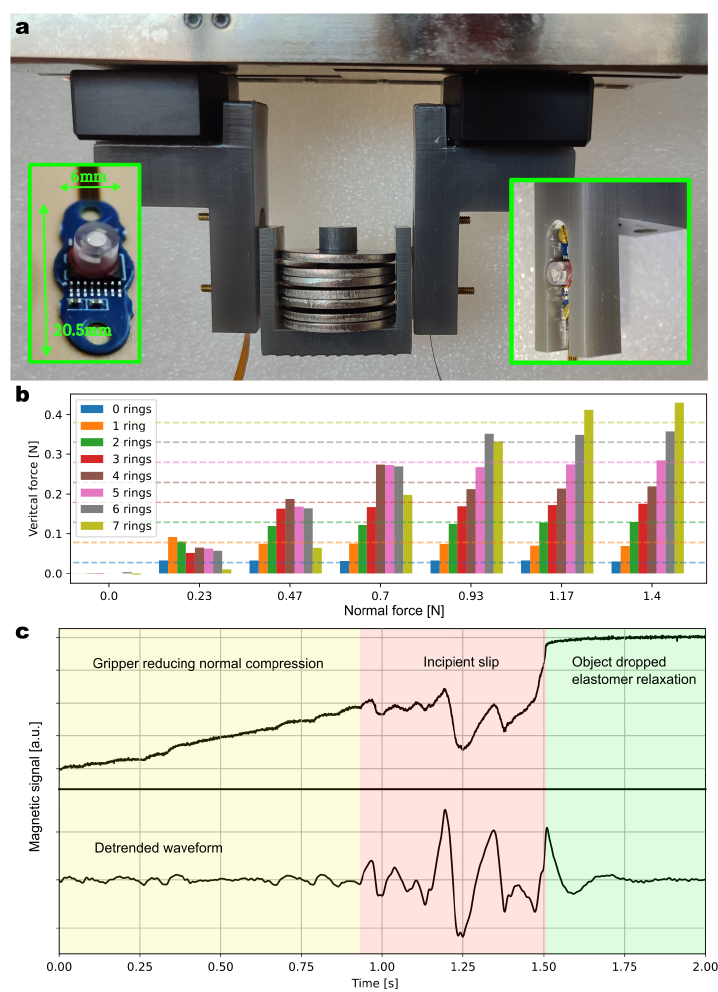
Figure 10. ( a ) Picture of the experimental setup, where two sensors are integrated in the jaws of a Schunk gripper. ( b ) Shear force measurement at different compression forces and mass loads. ( c ) Dynamic waveform acquired at the time of slippage: raw waveform ( top ) and detrended waveform ( bottom